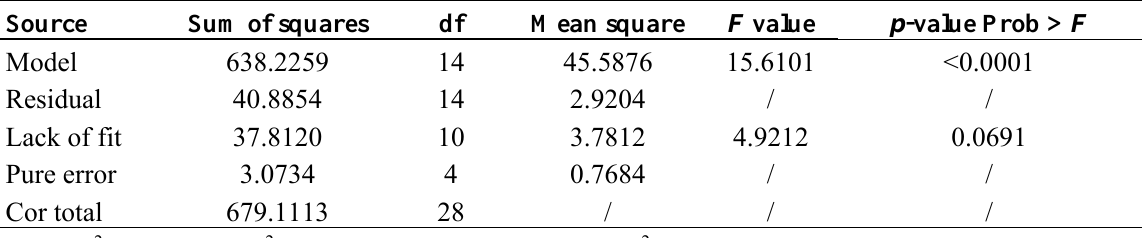
Table 2. Variance analysis of regression